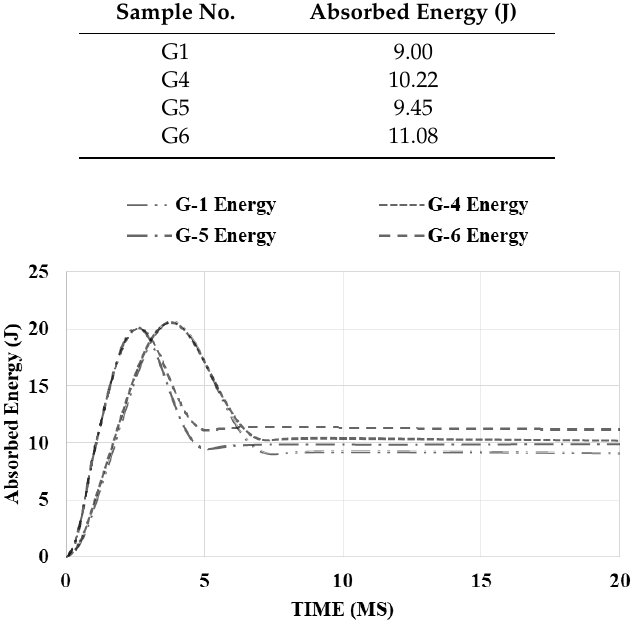
Figure 7. Absorbed energy for different glass-fiber epoxy.